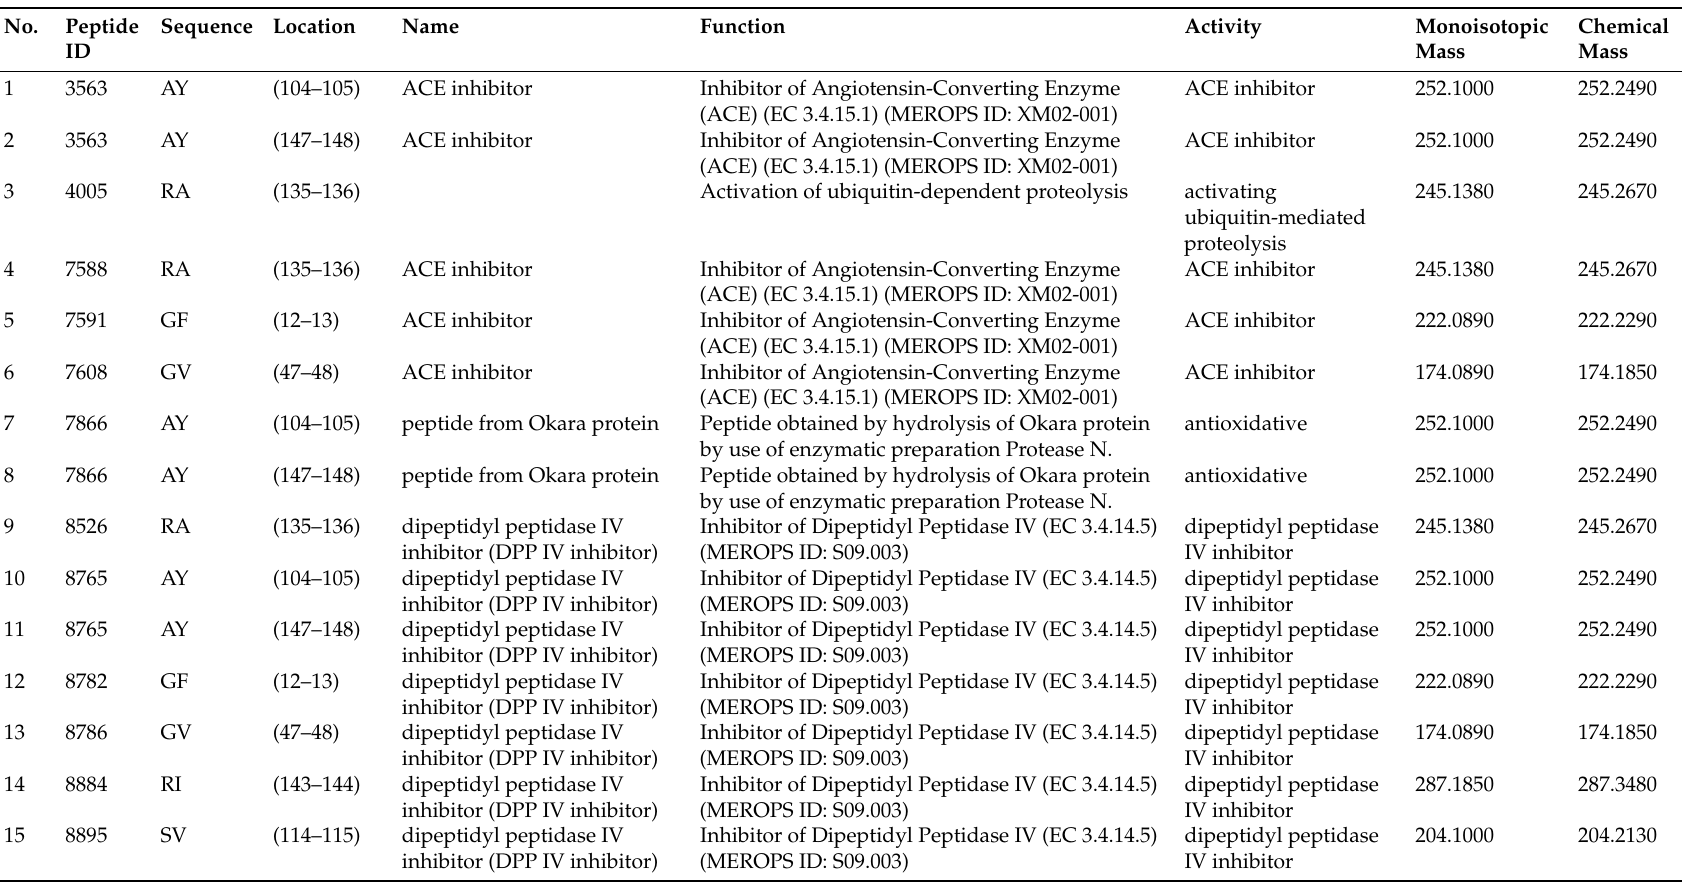
Table A47. Bioactive peptides from RubisCO of Halophila stipulacea . In silico enzymatic cleavage was carried out by using proteinase P1